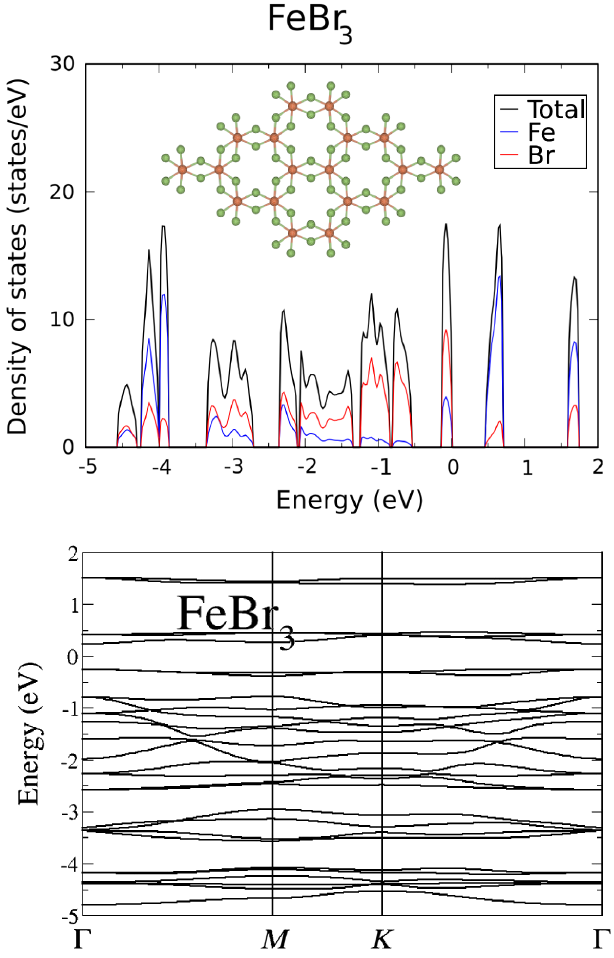
shown.FIG. 2. Density of states (upper panel) and band structure along the high-symmetry directions (cid:3) - M - K - (cid:3) (lower panel) of . Note that the density of states is also antiferromagnetic FeBr 3 shown as an atomic projected property. Also, the Fermi level is at zero. In the inset of the upper panel, the two-dimensional crystal structure is also